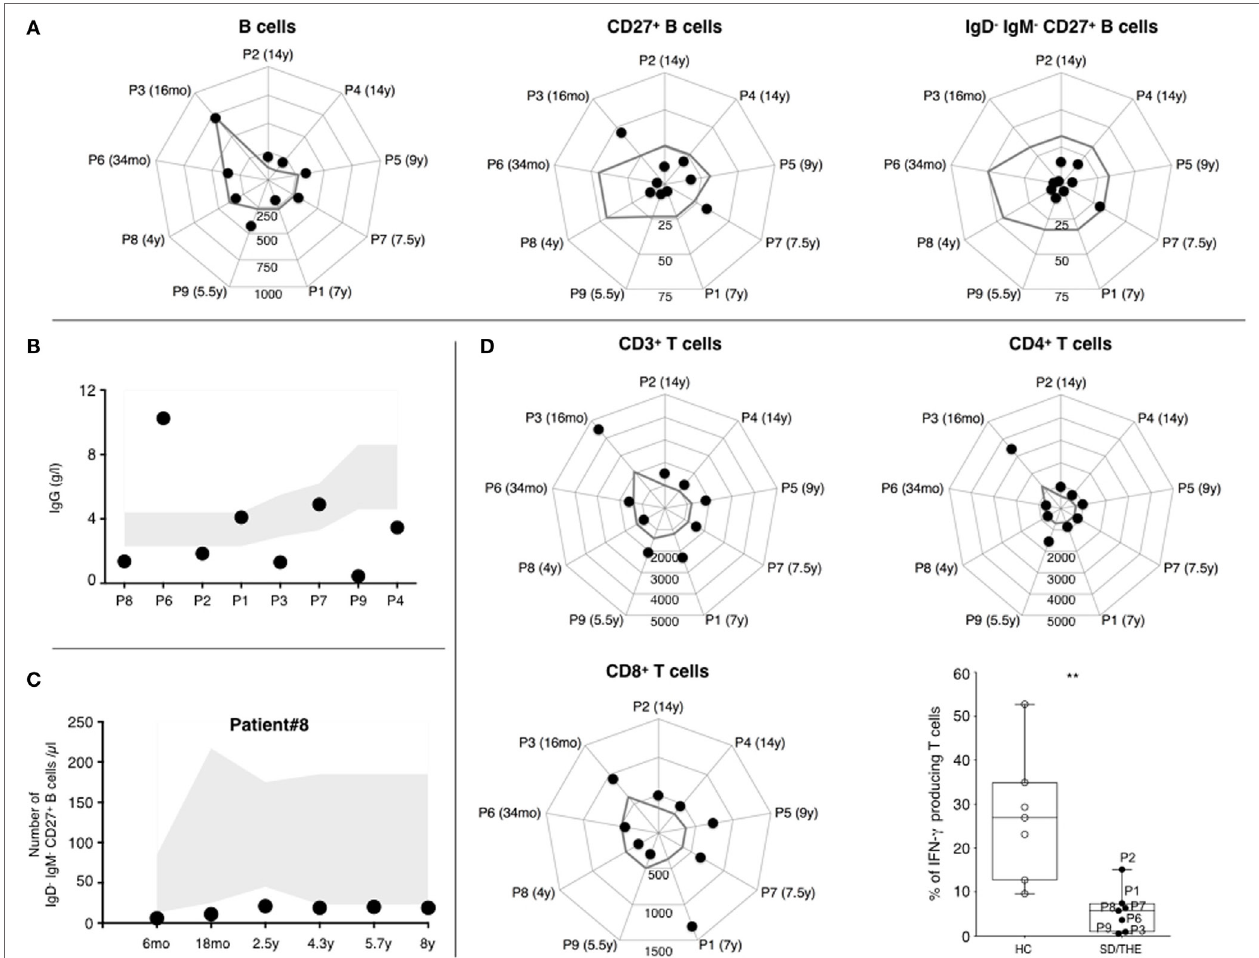
FIgURe 1 | Phenotypic and functional analysis of B and T lymphocytes. (a) Absolute numbers of CD19 + B lymphocytes, CD19 + CD27 + memory B lymphocytes, and CD19 + IgM − IgD − CD27 + switched memory B lymphocytes (cells per μ l). (B) IgG level at the age of diagnosis. Normal values are indicated as a gray area. (C) 8-years follow-up of B cell subsets in a syndromic diarrhea/trichohepatoenteric syndrome (SD/THE) patient. Absolute numbers of CD19 + IgM − IgD − CD27 + switched memory B lymphocytes (cells per μ l). Normal values are indicated as a gray area. (D) Counts of total CD3 + , CD3 + CD4 + , and CD3 + CD8 + T cell subsets (cells per μ l). The gray line indicates the lower limit of normal values according to the age. T cell functions evaluated by their ability to produce interferon gamma (lower right panel) after PMA/ionomycin activation as previously described (9). Healthy controls ( n = 7) and patients ( n = 7) are indicated as open circles and closed circles, respectively. Box-plot with medians, 25th–75th percentiles, and min–max values are shown. ns, not significant, p > 0.05; * p < 0.05; ** p < 0.01; *** p < 0.001; *** p < 0.001; *** p < 0.001 (Mann–Whitney